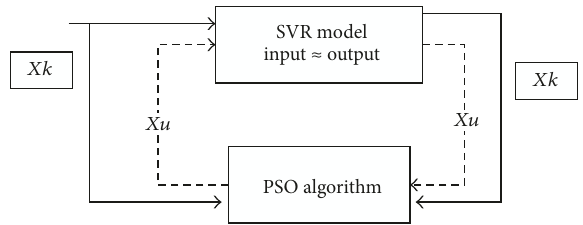
Figure 3: The process of the SVR-based imputation method with